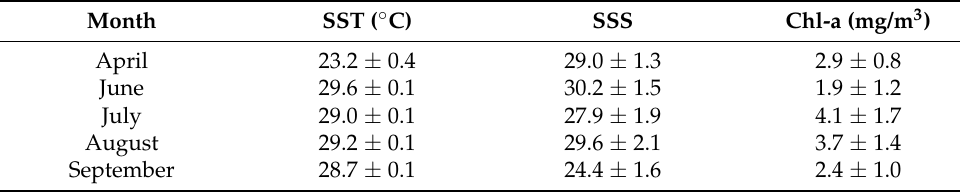
Table 3. Accuracy validation of HSI models.